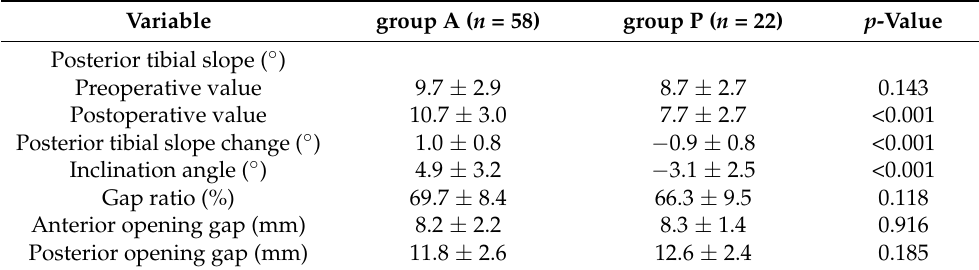
Table 4. Preoperative and postoperative measurement in the three-dimensional